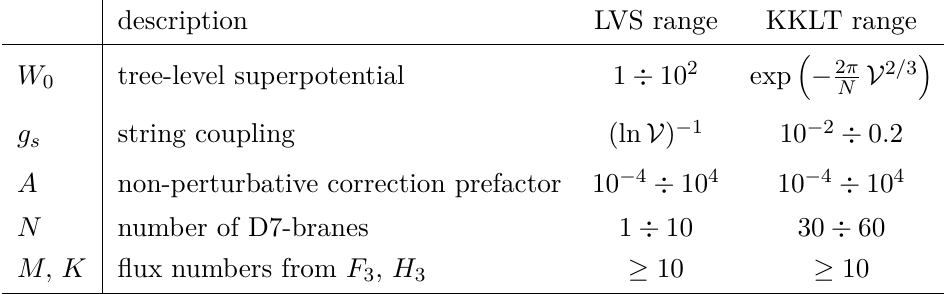
Table 2 . Description of microscopic parameters and their associated ranges considered in the study of closed string axions in LVS and KKLT moduli stabilisation. Where we provide a functional form, i.e. g in LVS or W in KKLT, no a priori range can be given. For instance, W s 0 as a parameter in KKLT as its value fixes the whole stabilisation. The same reasoning applies to g s in LVS. For simplicity, we do not make any assumptions about the distribution of parameters. The parameter ranges are chosen according to model building literature [25,